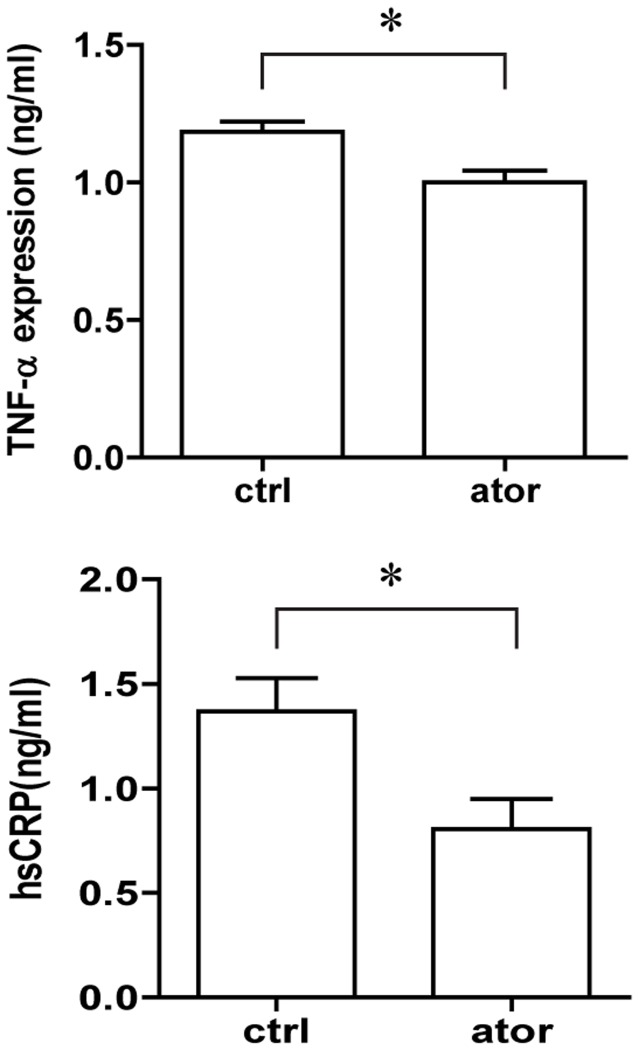
Effect of atorvastatin (10 mg/kg/d ) on plasma inflammatory markers TNF-α and CRP in ApoE-/- mice.Blood was collected 8 weeks after isosmotic saline or atorvastatin administration. Data represent the mean ± SEM of six ELISA experiments. *p<0.05 compared with control.